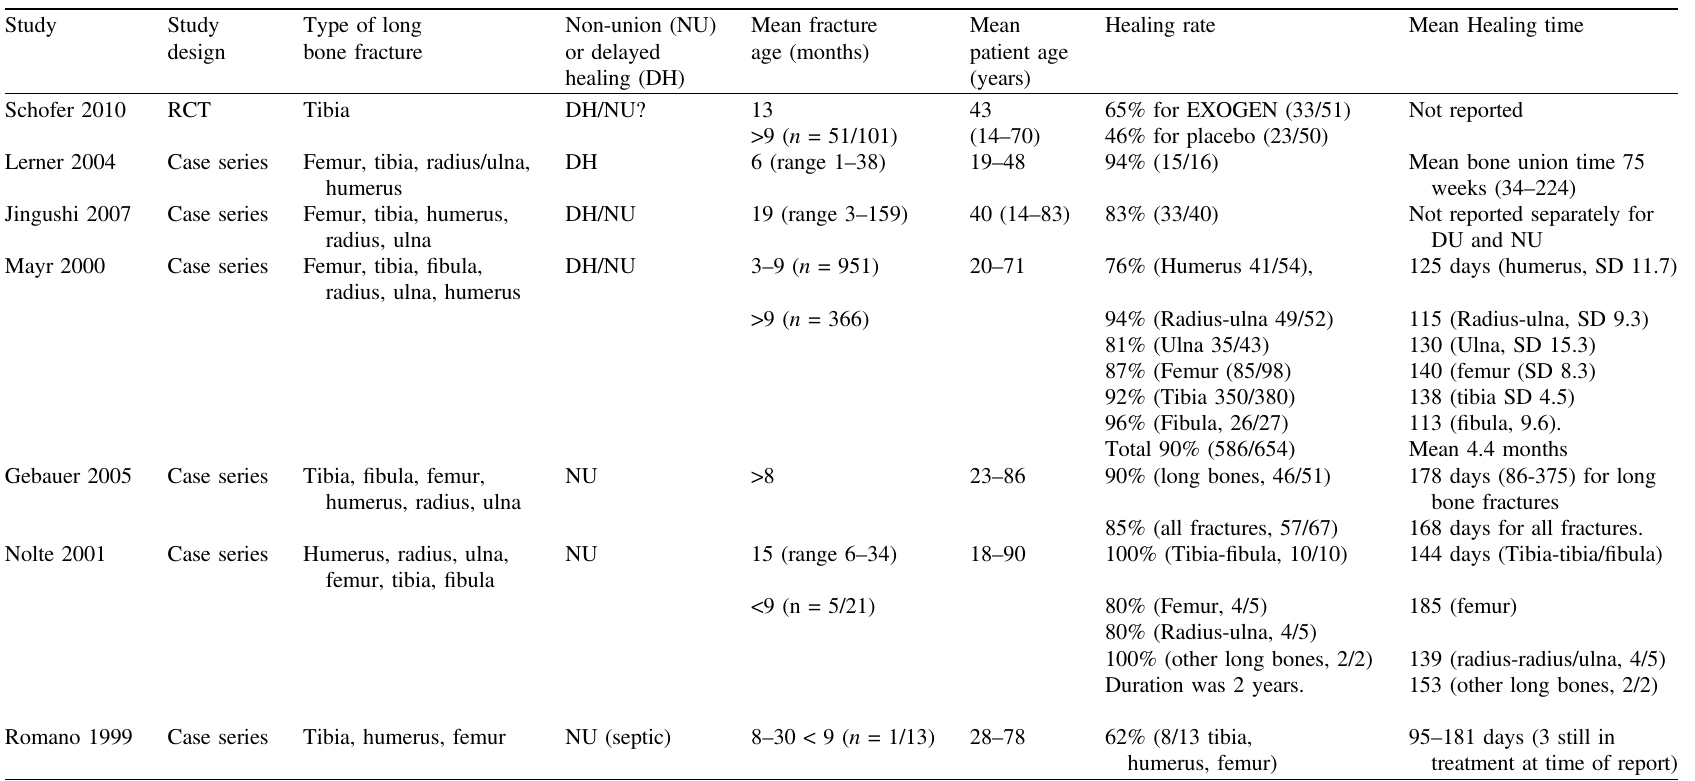
Table 2. Summary of clinical evidence from published studies used within the NICE assessment review (adapted from Tables 1, 2, & 7 in the External Assessment Centre